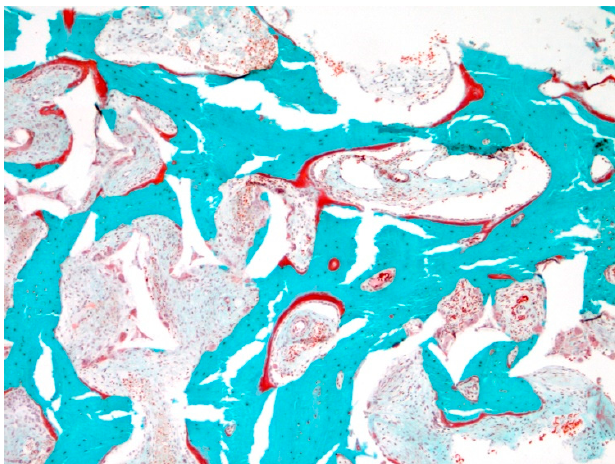
Figure 3. Increased bone formation following the shape of the grafted particles in a maxillary bone biopsy after a maxillary sinus floor elevation procedure from a patient with autogenous bone mixed with Straumann ® bone ceramic (60:40) after 6 months healing time, stained with Goldner trichrome staining. No Howship’s lacunae could be detected on the characteristic outlines of the calcium phosphate particles. (original magnification ×100).